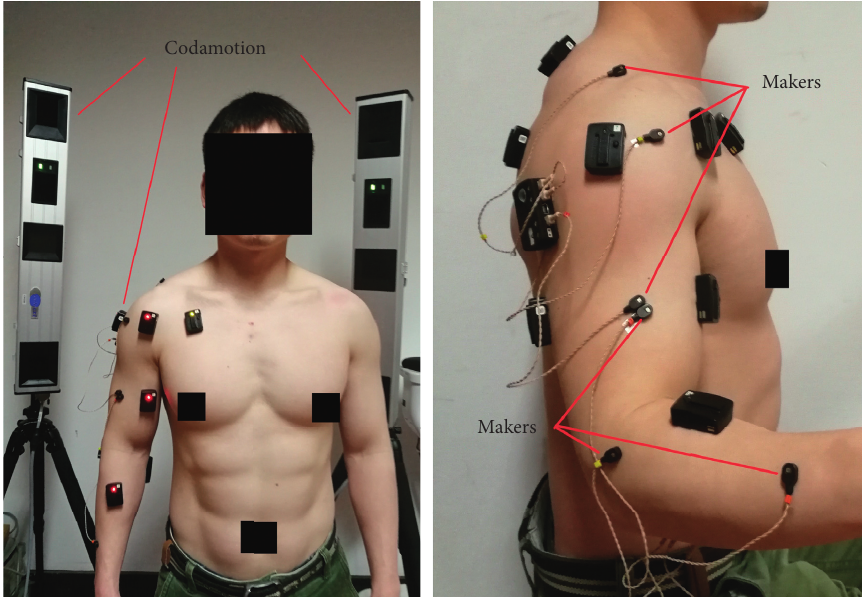
Figure 3: Codamotion system and placement of